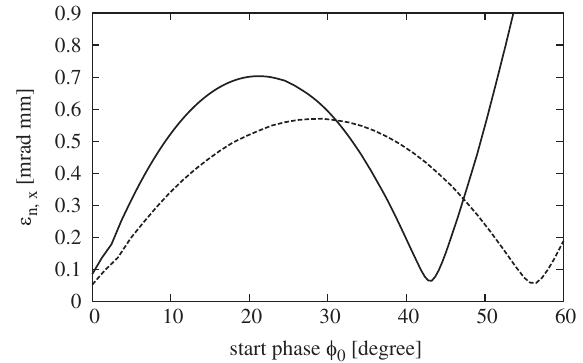
FIG. 17. Compensation of the rf-induced emittance by a third harmonic cavity. The setup consists of a half-cell rf gun cavity ¼ 0 . 0 mm, σ ¼ 0 . 75 mm, (1.3 GHz, E 0 ¼ 50 MV = m, x x off ϕ ¼ 4 . 68 °), 5 cm drift, and a three-cell cavity (3.9 GHz, m E ¼ 3 . 1 MV = m) running at the third harmonic frequency. 0 FIG. 19. Emittance development inside a cavity cell (solid line). The cavity center is located at z ¼ 0 m and the beam ( σ x ¼ 0 . 75 mm, ϕ m ¼ 4 . 68 °) is passed on crest through the cavity. The dashed line shows the development of the transverse rms momentum in arbitrary